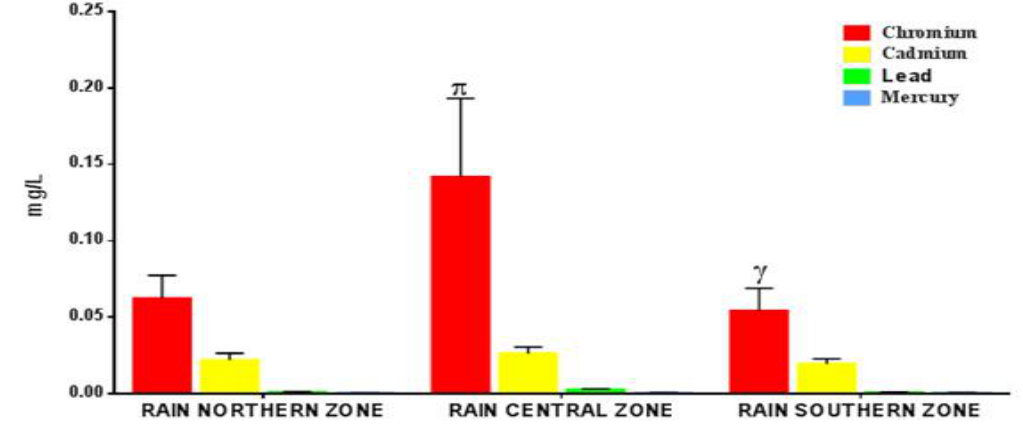
Fig. 7: Variation of mean distribution of heavy metals by geographical zones during the rainy season. Data are presented as the mean ± S.E.M. p value < 0.05. Statistical analyses were performed by two-way ANOVA test, followed by Uncorrected Fisher’s LSD test for multiple comparisons (P = 0.0008 (Cr RNZ Vs Cr RCZ), P = 0.0003 (Cr RCZ Vs Cr RSZ), P < 0.05). ð p versus rain cal cal northern zone group, ã p versus rain central zone